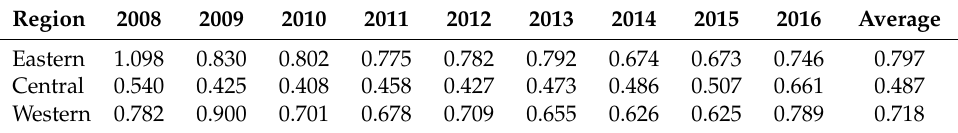
Table 3. Average values of provincial efficiencies within each region (2008–2016).